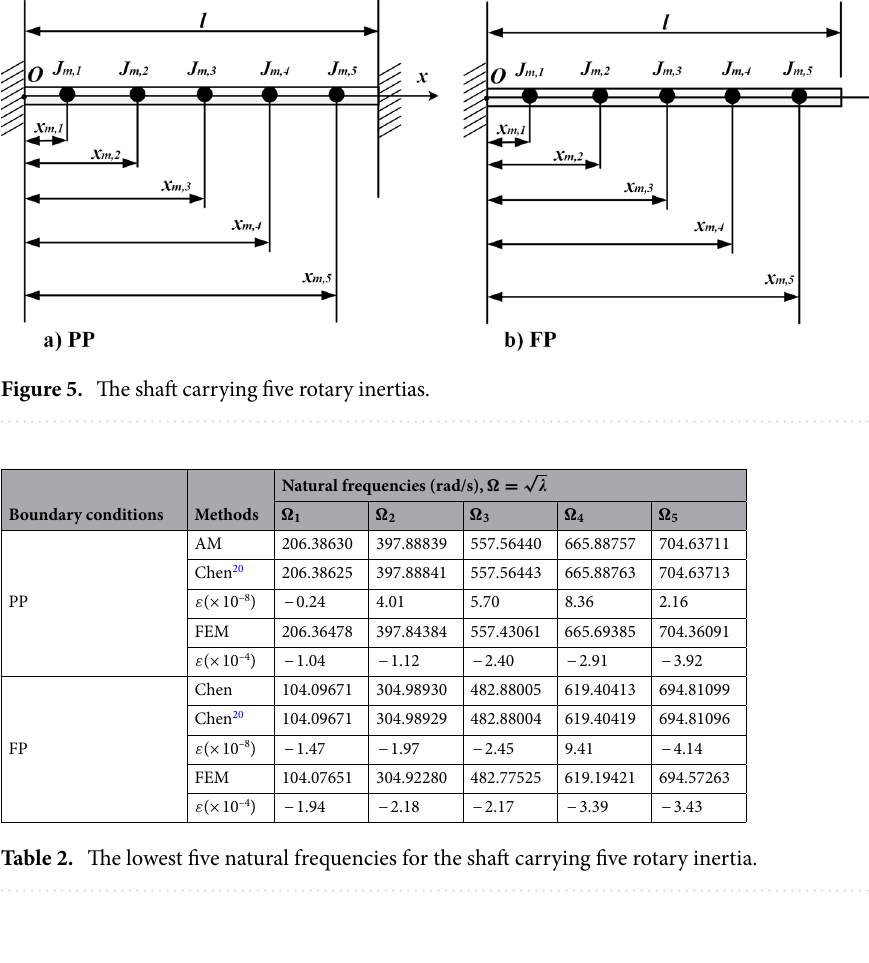
Table 2. The lowest five natural frequencies for the shaft carrying five rotary inertia.